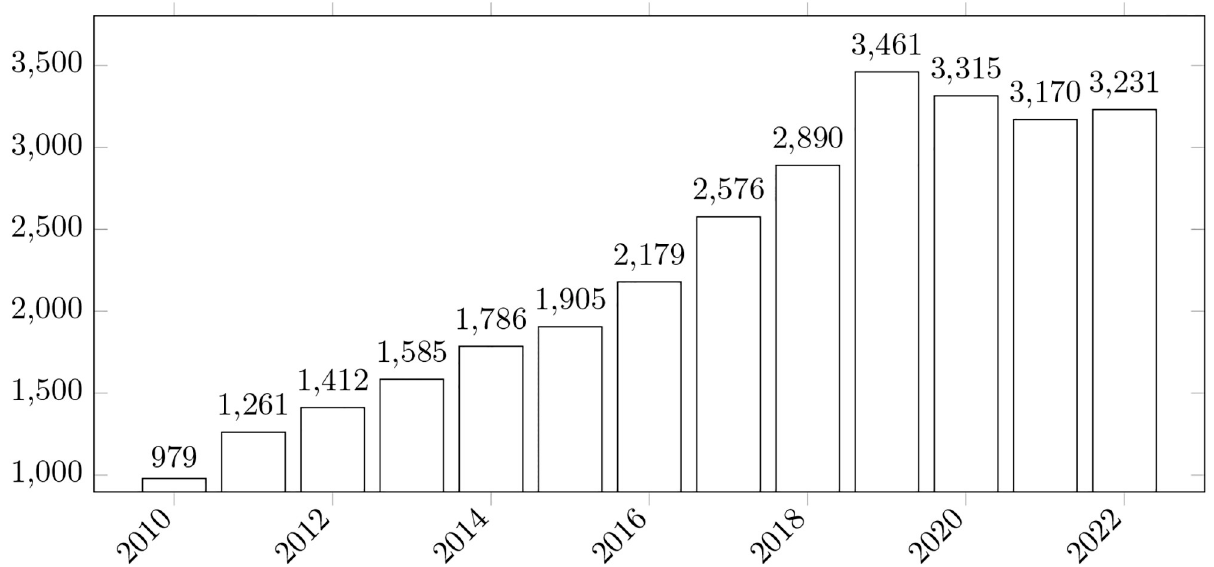
Fig 14. Papers distribution according to the query “recommender system” in scopus. The bars show the number of papers on the topic published between 2010 and 2022.